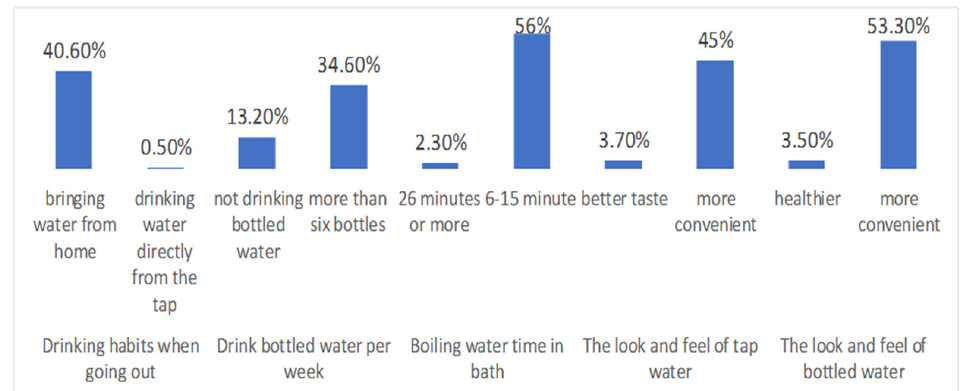
Figure 3. Water use awareness analysis.